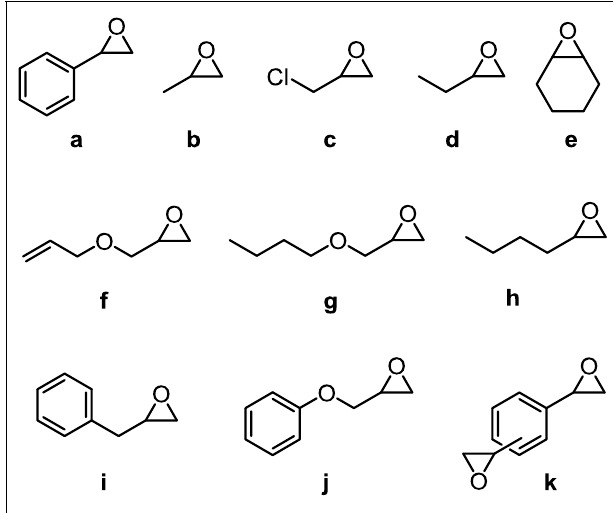
FIGURE 1 | Proposed mechanism for the acid (A)-catalyzed carbon dioxide insertion into epoxide in the presence of a tetraalkylammonium halide (bromide) (North and Pasquale, 2009) .